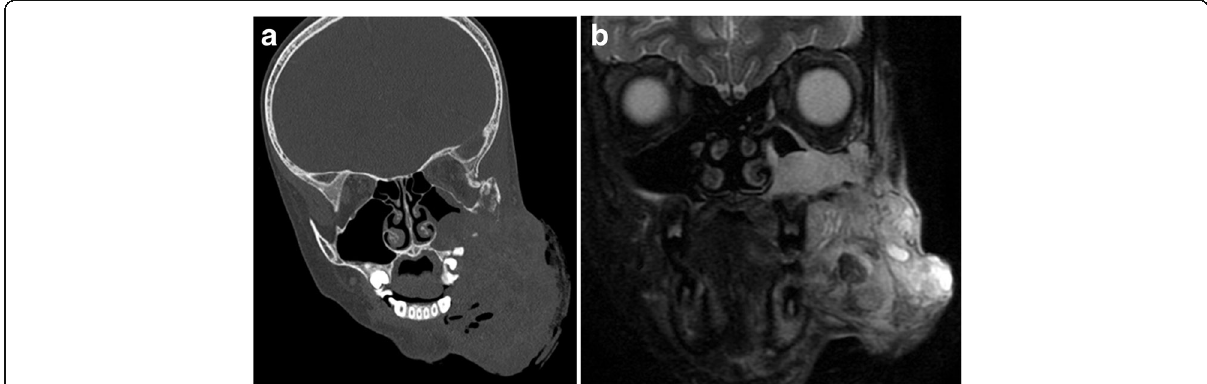
Fig. 5. Biphenotypic sinonasal sarcoma. Coronal CT ( a ) and fat-suppressed T2-weighted MRI ( b ) show an aggressive bulky mass involving the left maxillary sinus and lower face